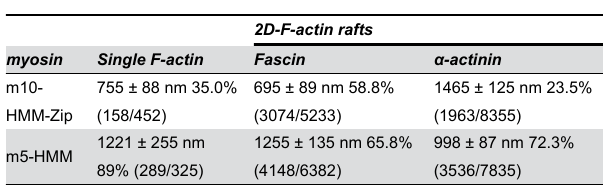
Table 1. The run-length (top) and the percentage (bottom) of the moement of m10-HMM-Zip and m5-HMM on single actin filaments and F-actin rafts.